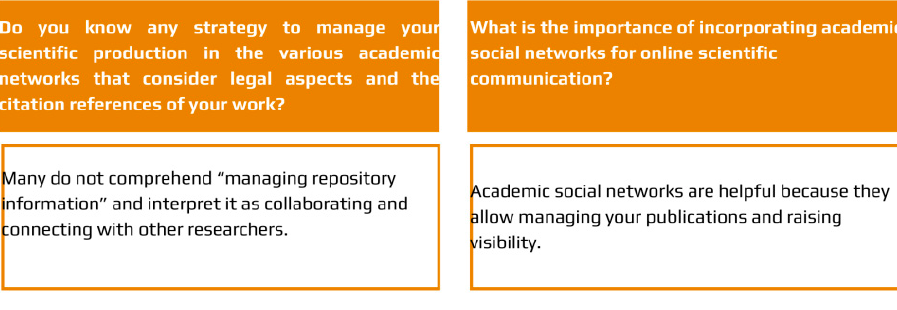
Figure 5. Results of the management of digital identity 2.0. (Own